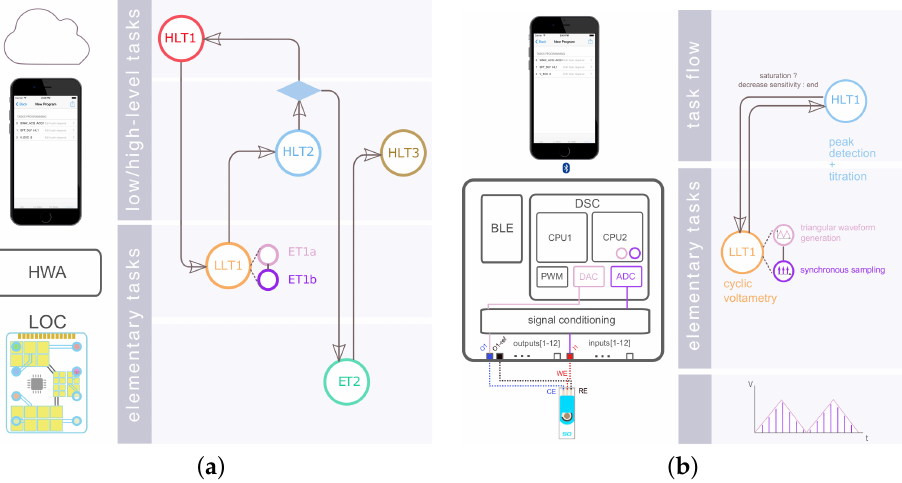
Figure 2. ( a ) Generic illustrative example. The LoC program starts with a high-level task HLT1 carried out by in the cloud followed by a low-level task LLT1 performed by the HWA. A predicate on the execution of HLT2 conditions the next task to be executed: if the program branches to ET2, the program eventually ends by HLT3; otherwise, it loops to the beginning. ( b ) Cyclic voltammetry acquisitions are carried out successively at decreasing sensitivities if current saturation is detected within the potential range where calibration is carried out. Cyclic voltammetry LLT1 is composed of two synchronous elementary tasks: triangular waveform generation and synchronous